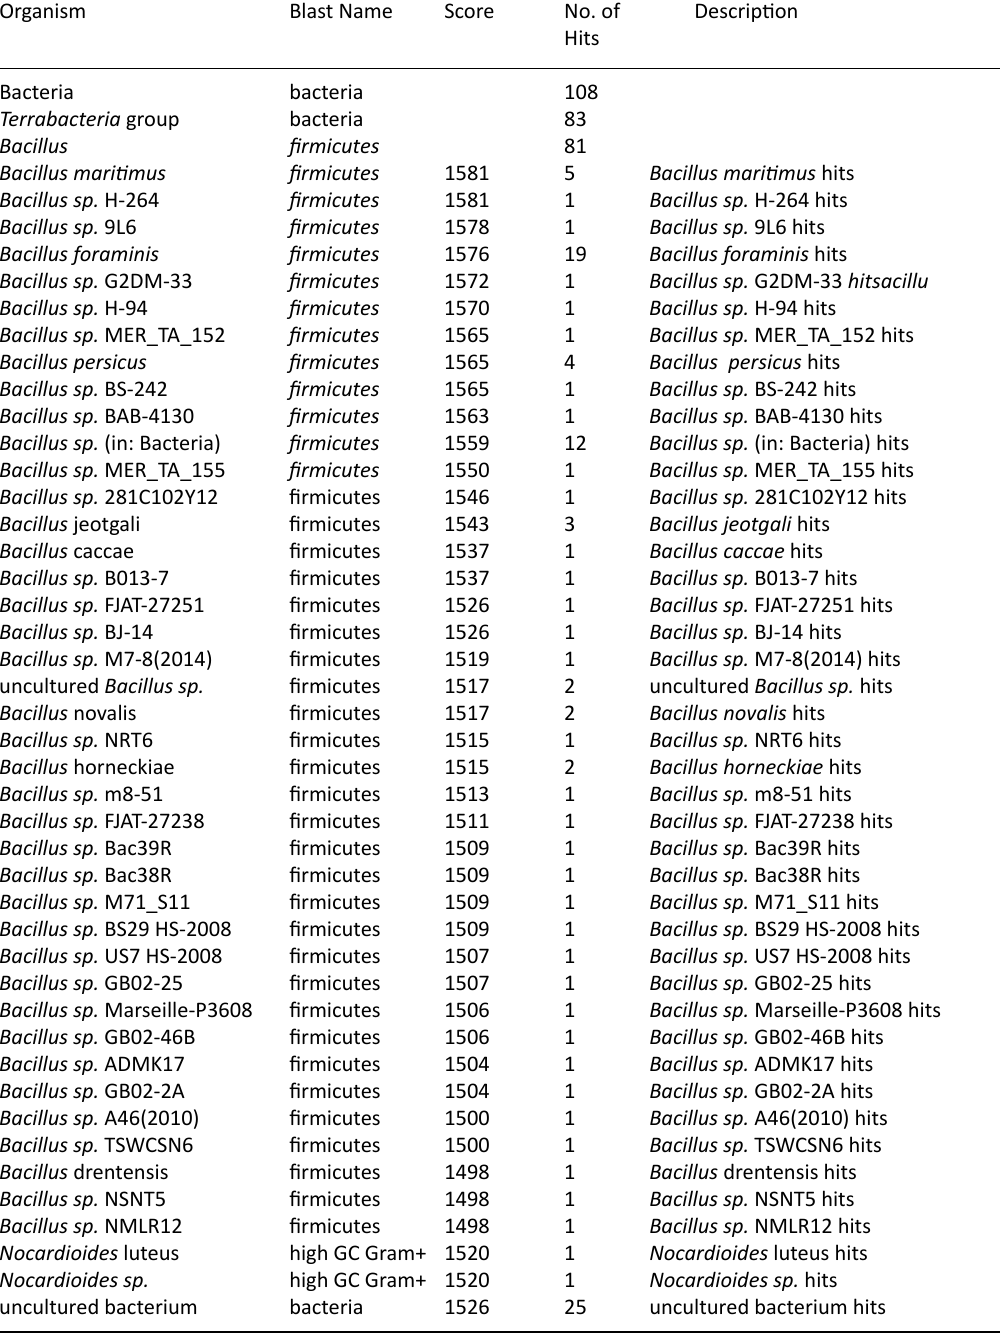
Table 1. The taxonomical analysis of Bacillus